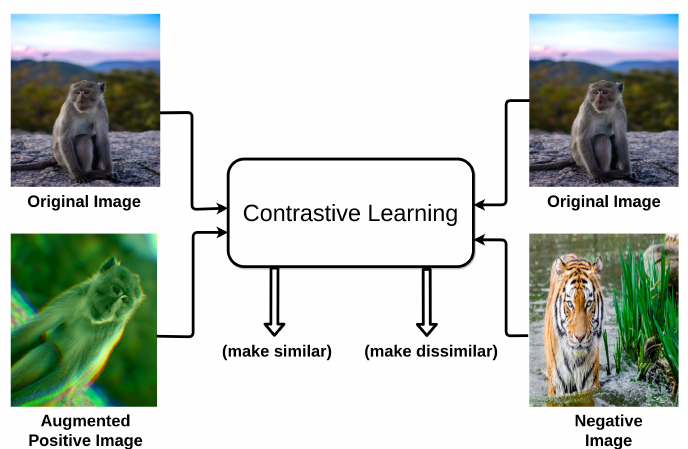
Figure 1. Basic intuition behind contrastive learning paradigm: push original and augmented images closer and push original and negative images